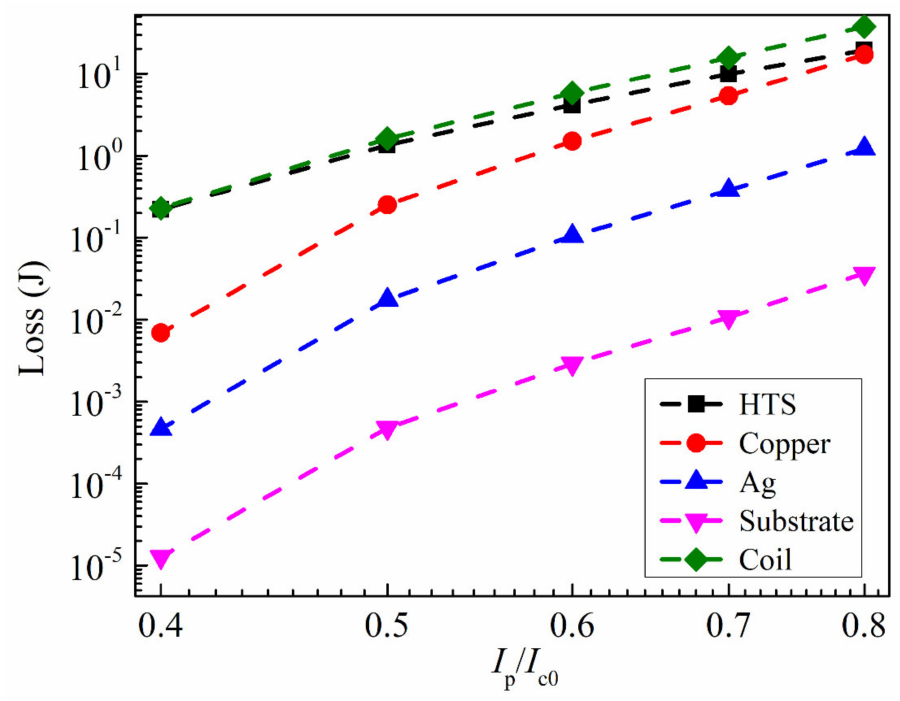
Figure 3. The loss variation in each part of the REBCO coil under fault currents of different